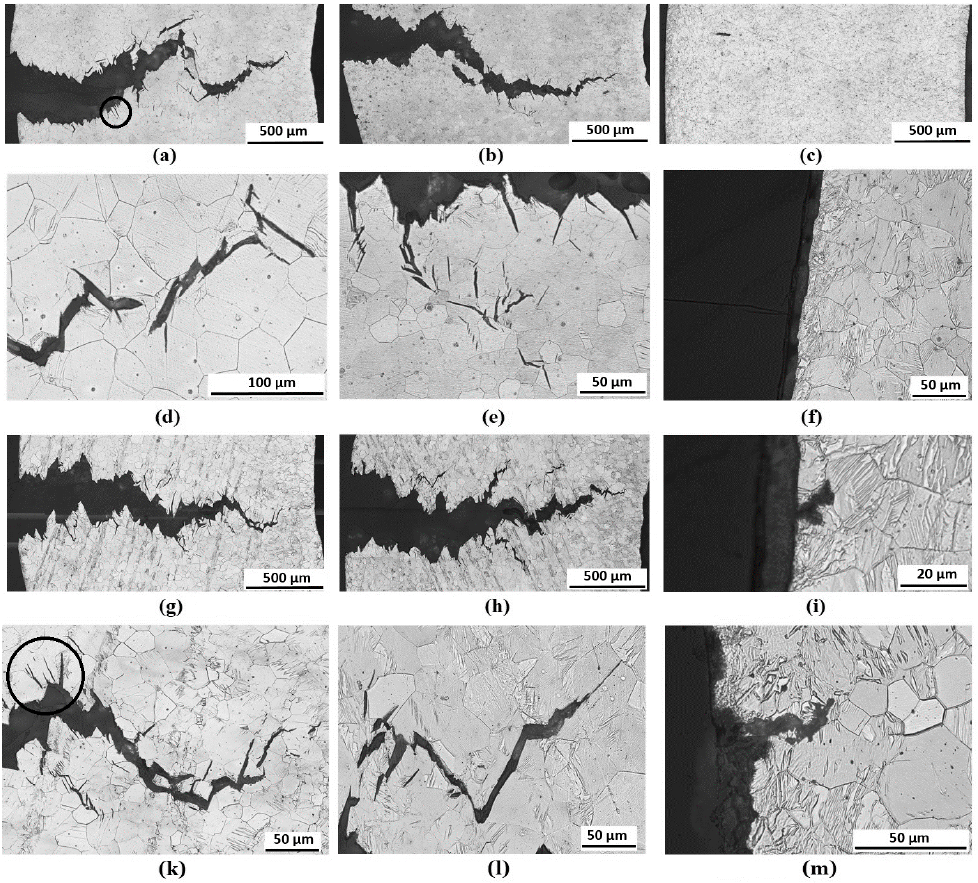
Figure 8. Cross-sectional optical micrographs of the crack path in the C-ring samples after compressive loading in Ringer solution: Mg10Dy1Nd ( a , d , g , k ), Mg10Dy ( b , e , h , l ) and Mg1Nd alloys ( c , f , i , m ). Micrographs showing full wall thickness of C-ring ( a – c , g , h ) and micrographs of higher magnification revealing detailed interaction of microstructure and crack growth ( d – f , i – m ), circled markers highlights parallel subcracks emanating from the main crack ( a , k ).